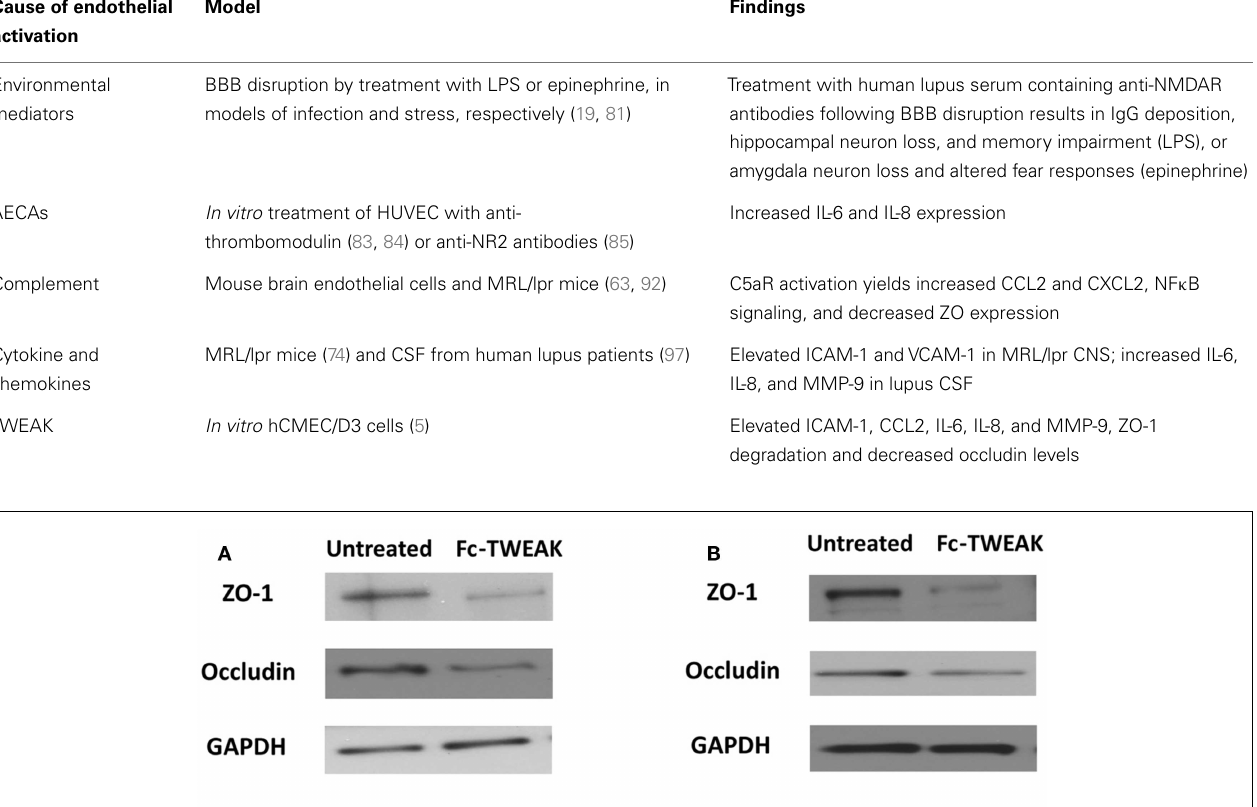
Table 1 | Potential routes of endothelial cell activation in SLE.